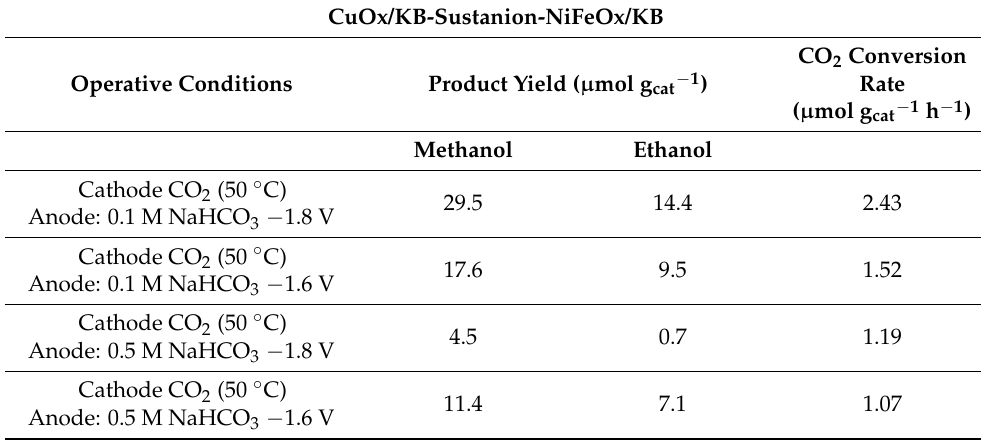
Table 1. Liquid-phase analysis for cell-based on CuO x /KB - Sustainion X37-50 -NiFeO x /KB.